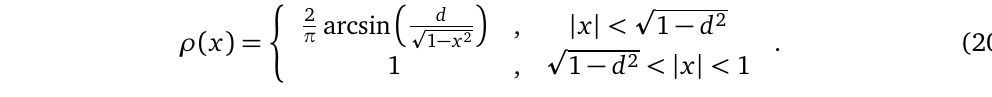
Top: a typical configuration for N = 16 particles on B . Bottom: density profile for N = 16 particles (Monte Carlo simulation) and comparison with the thermodynamic limit